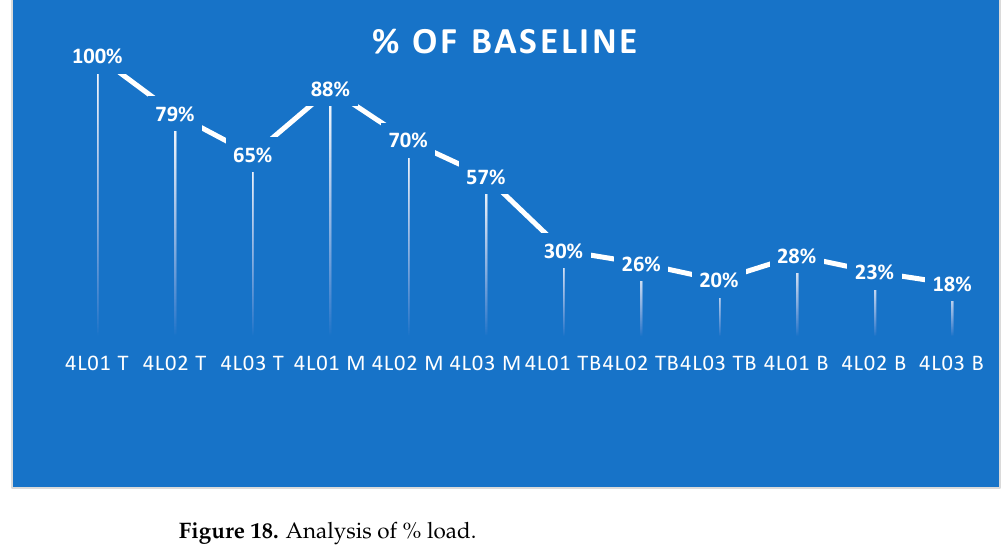
Figure 18. Analysis of % load.